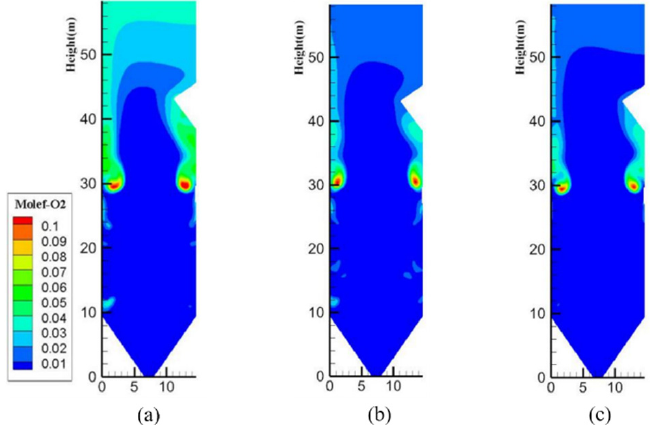
Figure 10. Variable combustion air opening 350 MW oxygen molar concentration distribution. ( a )